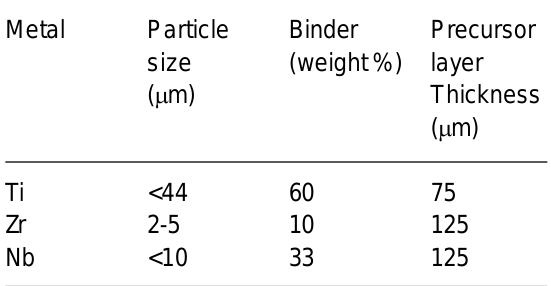
Table 1. Details of metal powder particles used to make the precursor coatings.